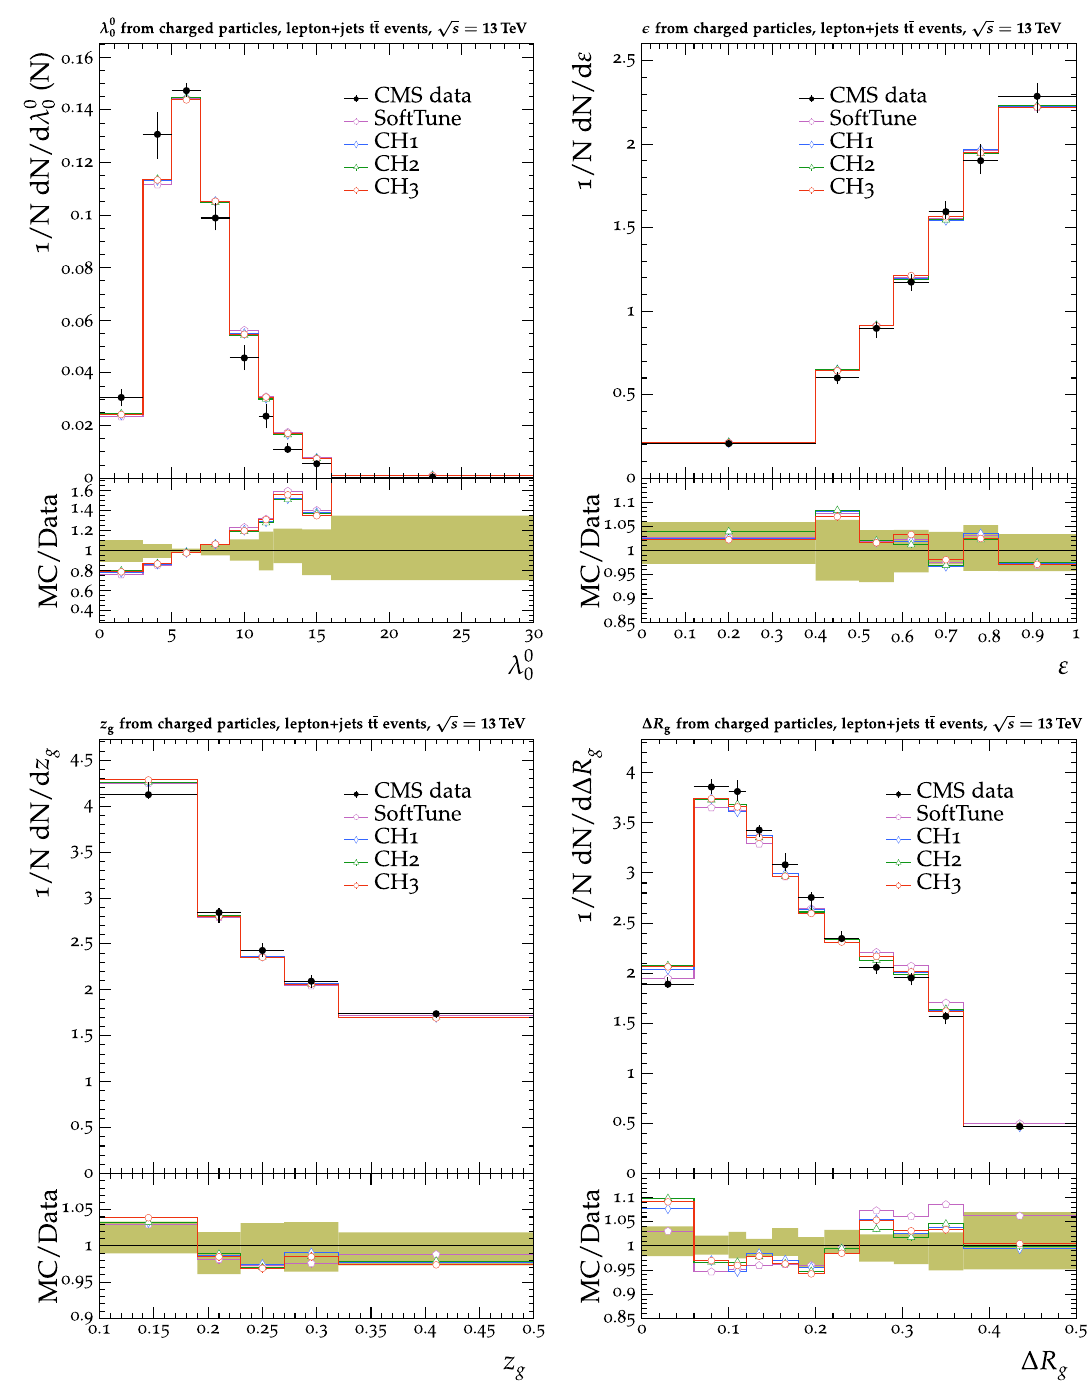
Fig. 14 The normalized jet substructure observables in single-lepton events: the charged-particle multiplicity (upper left); the eccentricity (upper right); the groomed momentum fraction (lower left); and the angle between the groomed subjects (lower right) [42]. CMS t ¯ tdata are compared with the predictions from powheg + herwig 7, with the